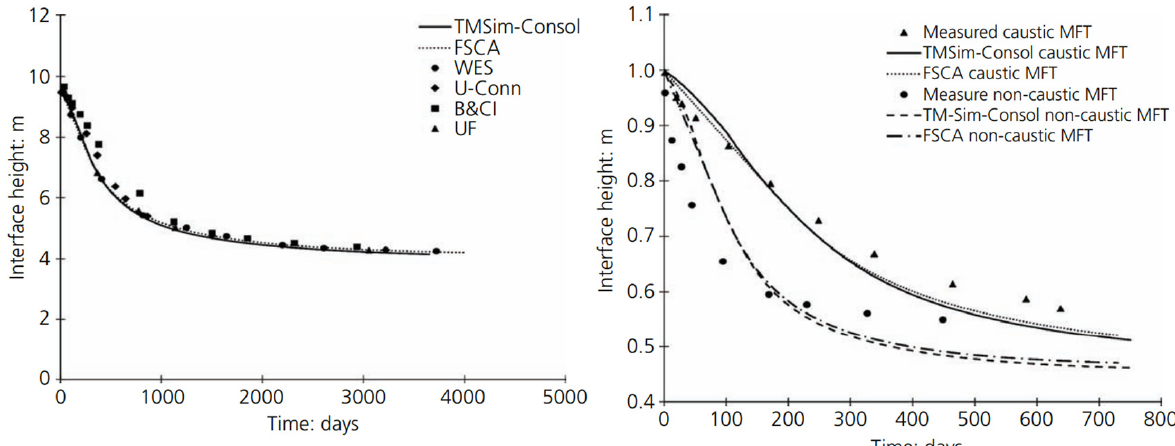
Figure 4. Comparison of settlement and interface height with time for the 1D model—adapted with permission from [30].